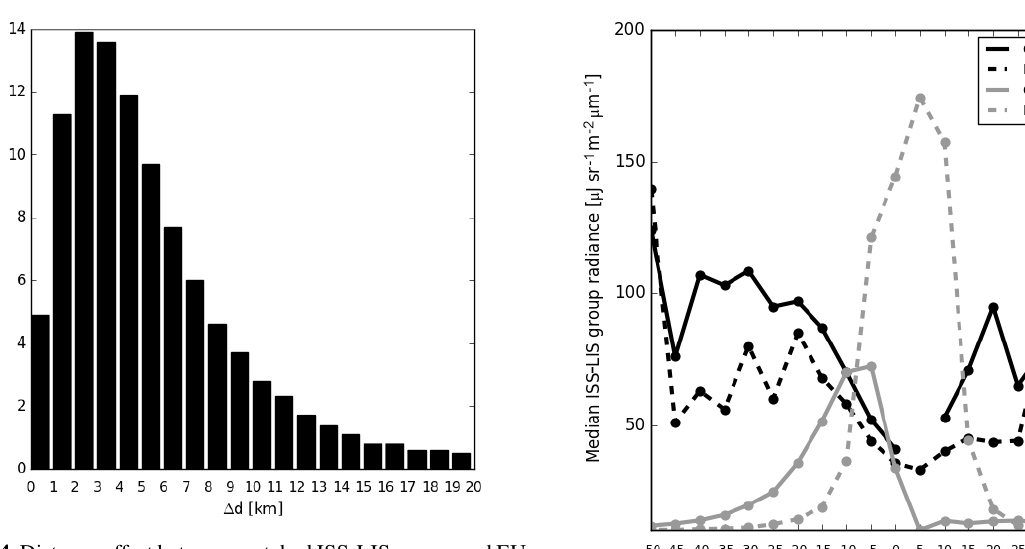
Figure 4. Distance offset between matched ISS-LIS groups and EU- CLID strokes and pulses.